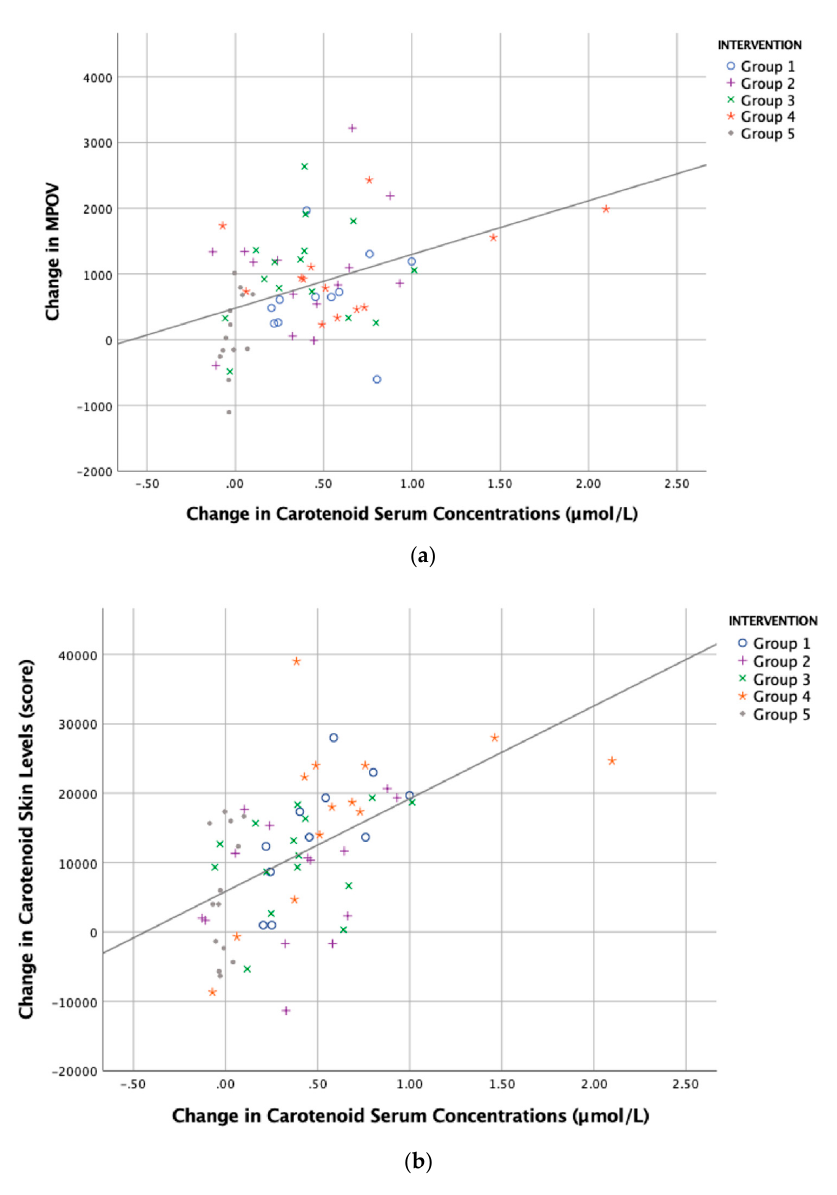
Figure 5. The relationship between the change in carotenoid serum concentration and change in tissue (response). Linear regression analyses of total carotenoid serum concentrations (L + Z + MZ) and ( a ) MPOV (r = 0.408, p = 0.001), and ( b ) carotenoid skin score (r = 0.528, p < 0.001). Interventions are as follows: Group 1, L (10 mg) + MZ (10 mg) + Z (2 mg) provided in one capsule; Group 2, L (10 mg) + MZ (10 mg) + Z (2 mg) provided in two capsules; Group 3, L (10 mg) + MZ (10 mg) + Z (2 mg) provided in DHA (430 mg) and EPA (90 mg) in two capsules; and Group 4, Ld (10 mg) + MZd (10 mg) + Zd (2 mg) provided in one capsule; or Group 5, placebo (sunflower oil).